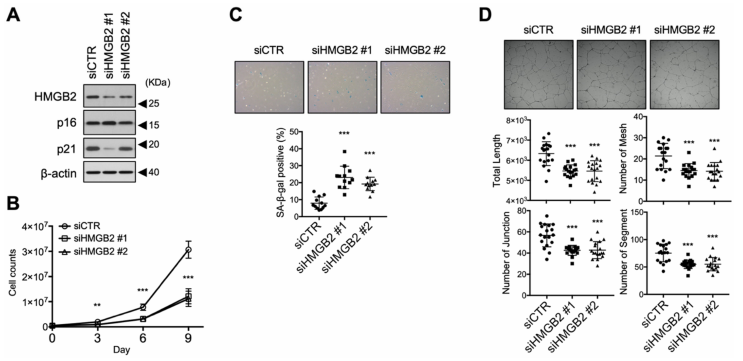
Figure 2. HMGB2 silencing induced premature senescence in MVECs. ( A ) Proliferating MVECs (PDL23) were transfected with two siRNAs designed to target HMGB2. Knockdown of HMGB2 was confirmed via immunoblot analysis. The expression levels of p16 and p21 are shown